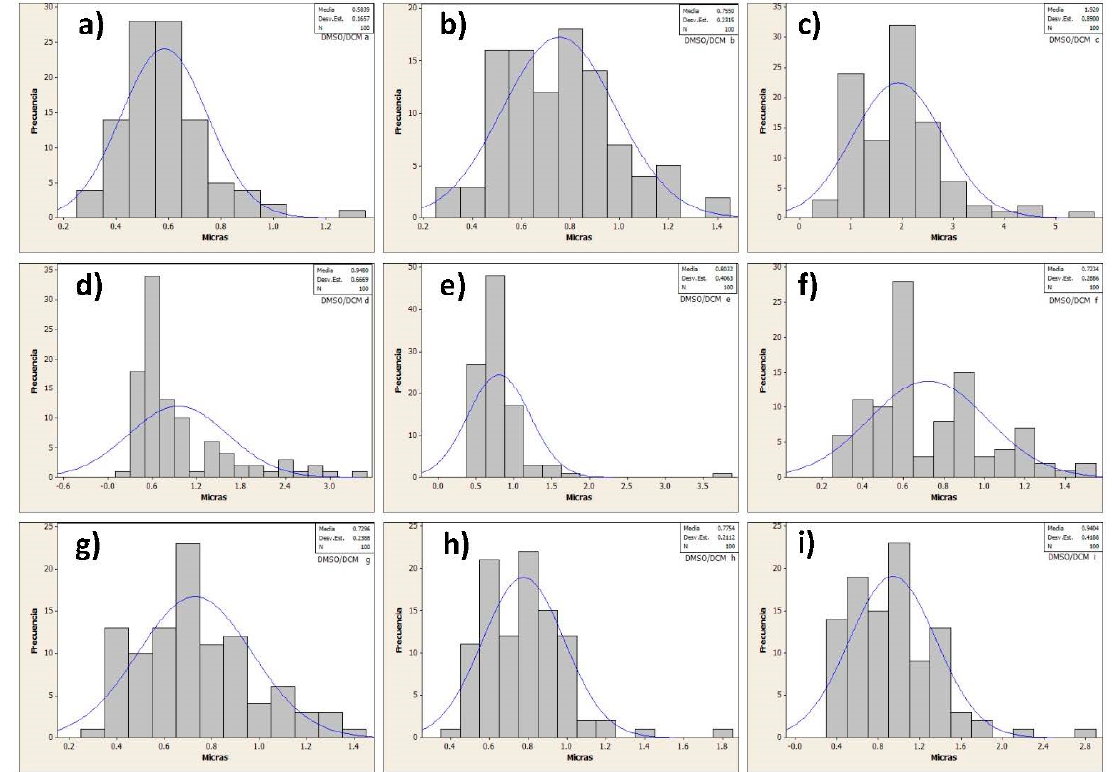
Figure 8. Optimization process of PCL (12%) electrospun in DCM/DMSO (dichlormethane/dimethyl sulfoxide): ( a ) 10 kV, 0.7 mL/h, 18 cm; ( b ) 10 kV, 0.7 mL/h, 14 cm; ( c ) 10 kV, 0.7 mL/h, 10 cm; ( d ) 10 kV, 0.5 mL/h, 14 cm; ( e ) 10 kV, 1.2 mL/h, 14 cm; ( f ) 10 kV, 2 mL/h, 14 cm; ( g ) 12 kV, 1.2 mL/h, 14 cm; ( h ) 14 kV, 1.2 mL/h, 14 cm; ( i ) 16 kV, 1.2 mL/h, 14 cm. SEM images ( top ) and size distribution ( bottom ).